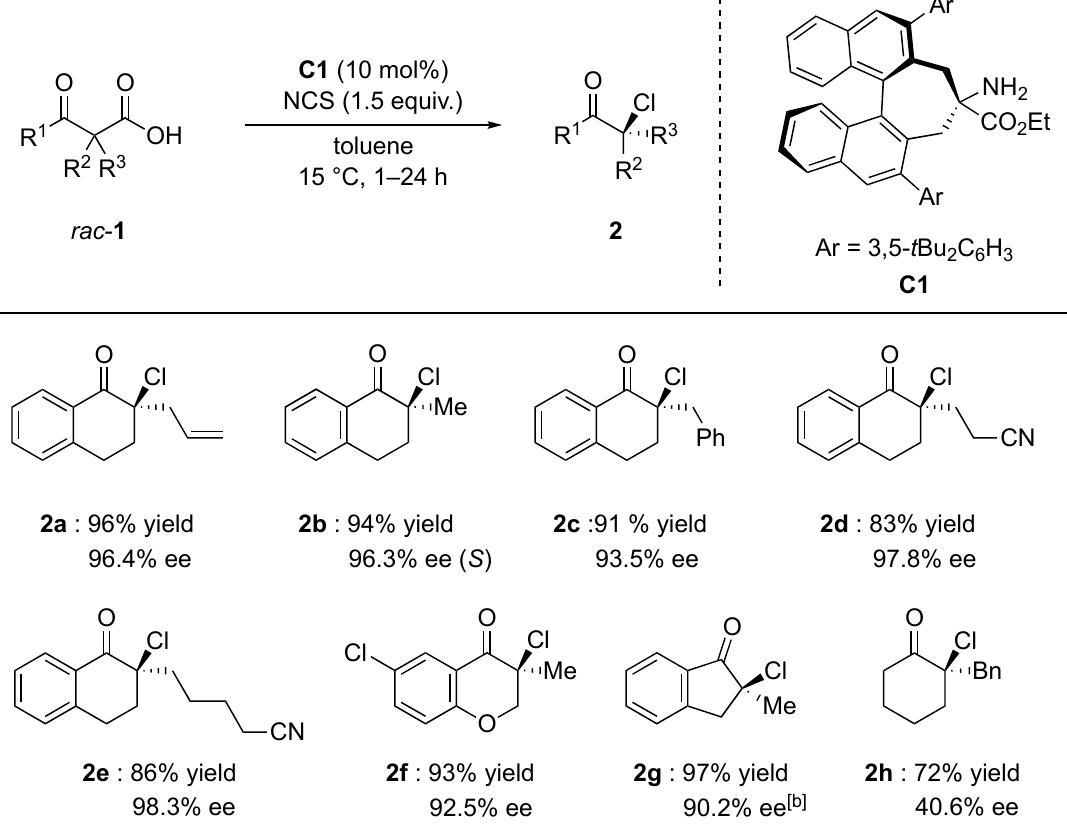
Figure 1. Synthesis of optically active α -chloroketones 2 [a] ( [a] Reactions were carried out with 10 mol% C1 and 1.5 equiv. of NCS at ambient temperature in toluene (0.2 M), unless otherwise noted. [b] Reaction was carried out for 2 days at –20 °C).